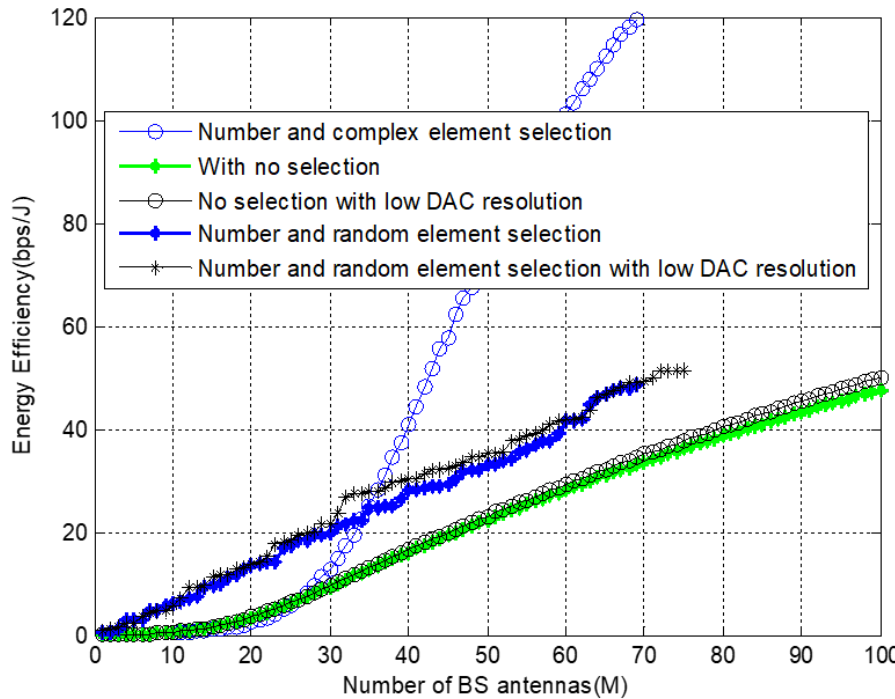
Figure 11. Energy efficiency with and without low resolution DAC at f = 38 GHz and M =